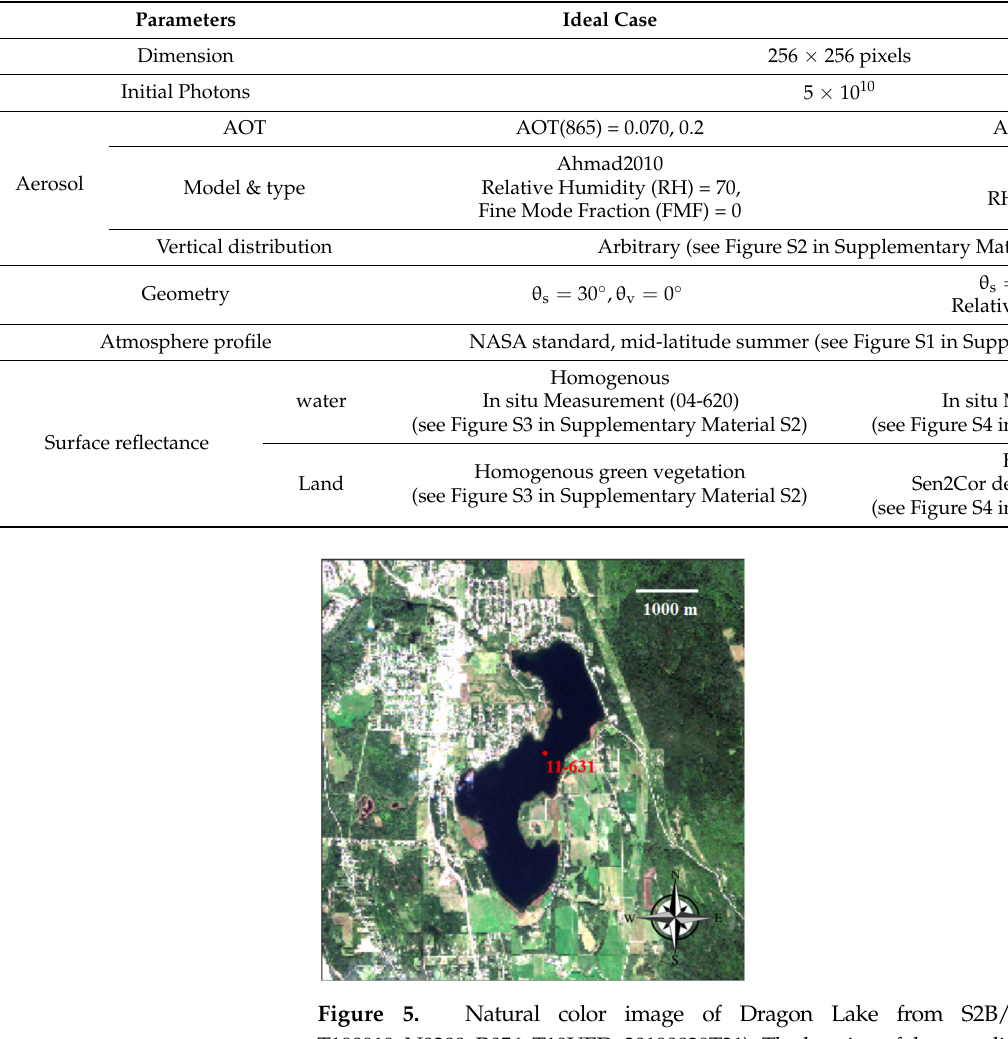
Table 3. Main inputs of the 3D simulation.